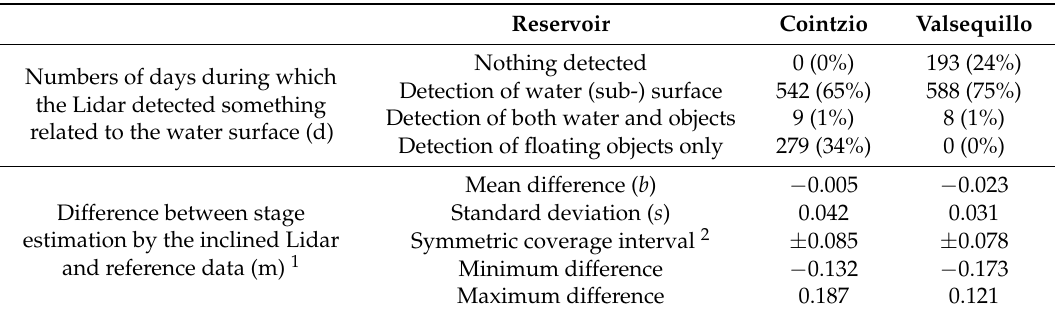
Figure 10. Main results of the field experiment at Valsequillo (same legend as Figure 9). Table 1. Performances of the proposed technique during the field